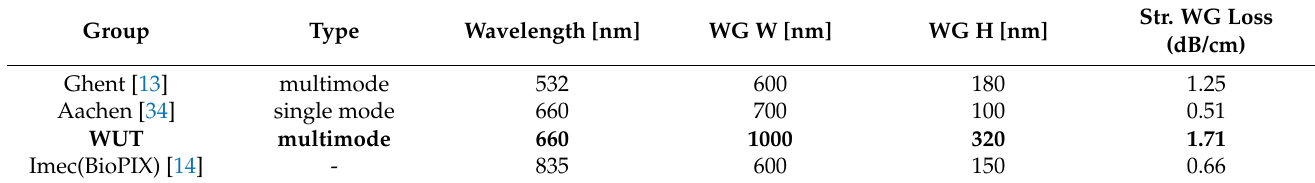
Table 5. Comparison of WGs’ performance in SiN-based platforms for VIS